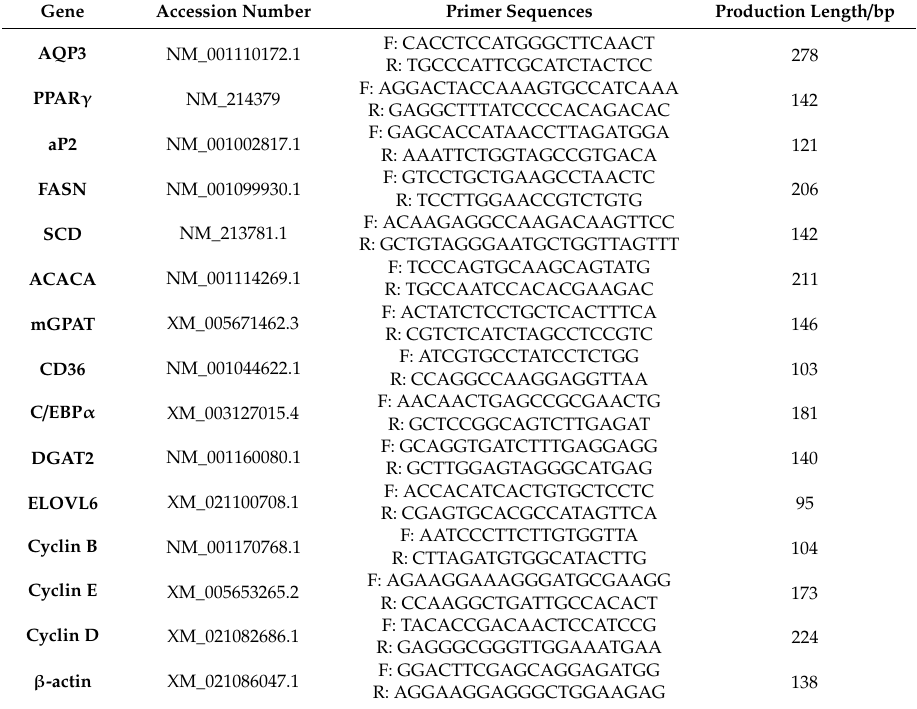
Table 1. Primer sequences for real-time